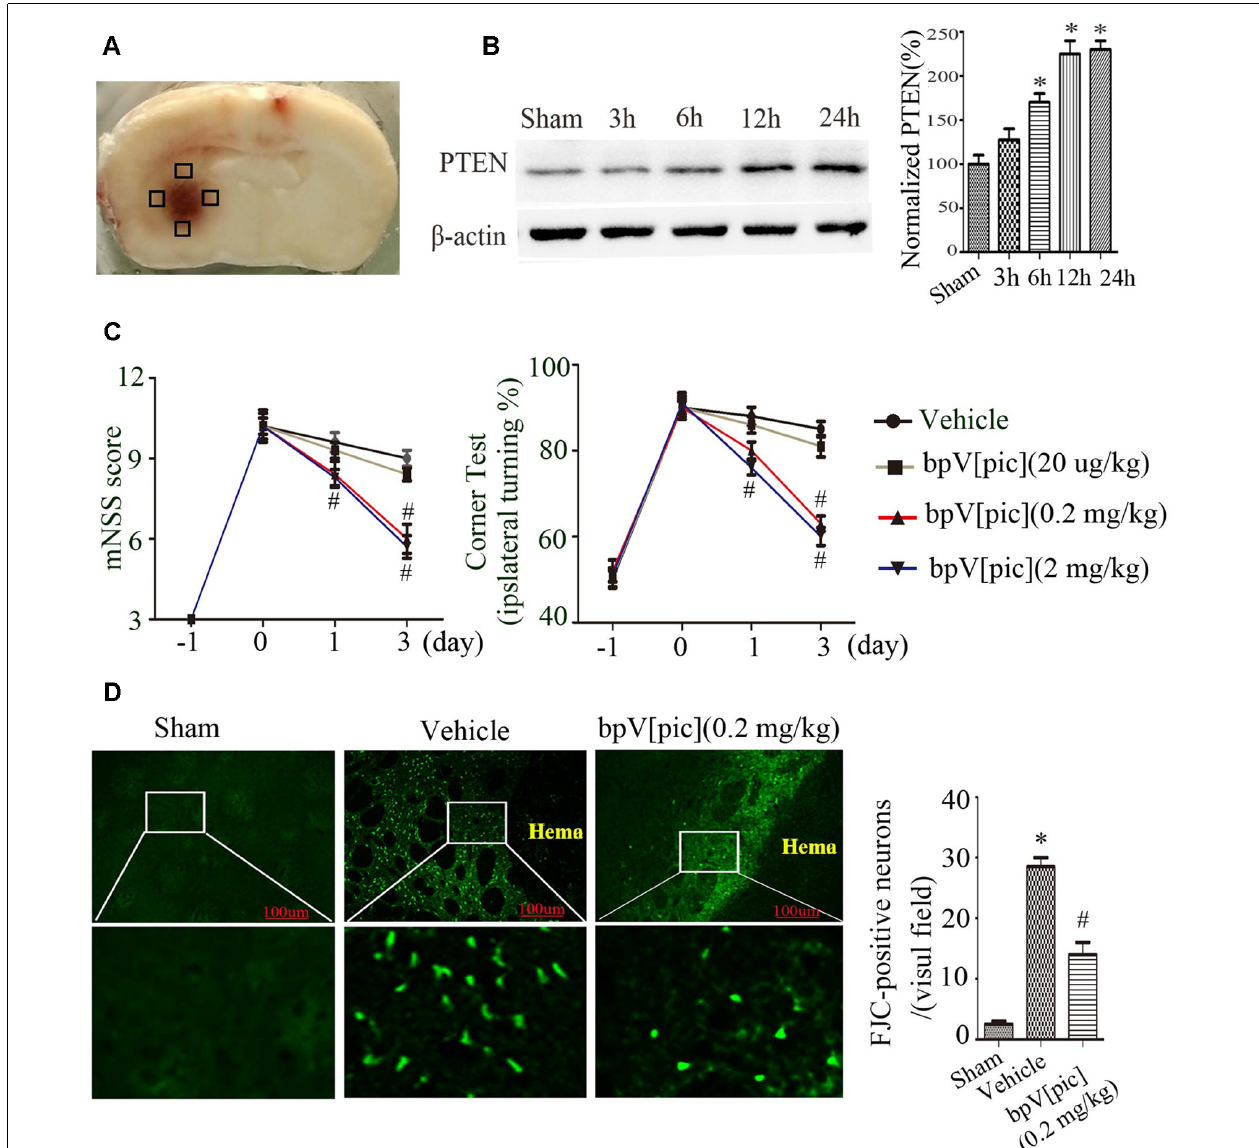
FIGURE 1 | Dipotassium bisperoxo (picolinato) oxovanadate (V), (BpV[pic]) attenuated neurological deficits and decreases neuron loss after intraceberal hemorrhage (ICH) induction. (A) Represents the slice of rat brain 24 h after experimental ICH. Black box represents the four sites around the hematoma of the Western blot experiment. (B) Expression of phosphatase and tensin homolog (PTEN) at different time points after rat ICH. (C) Neurological tests were performed in rats receiving vehicle or bpV[pic] (20 µ g/kg, 0.2 mg/kg, 2 mg/kg). (D) Rats received vehicle or bpV[pic] at a dose of 0.2 mg/kg 0.5 h after ICH by intraperitoneal injection. Fluoro-Jade C (FJC)-positive neurons were tested in the peri-hematoma 24 h after ICH ( ∗ p < 0.05 compared to Sham, # p < 0.05 compared to Vehicle. One-way ANOVA test, followed by Bonferroni post hoc test, N = 8